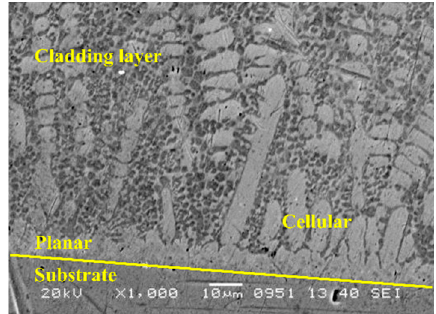
Figure 3. Typical microstructure at the junction between 316L SS substrate and coating in sample